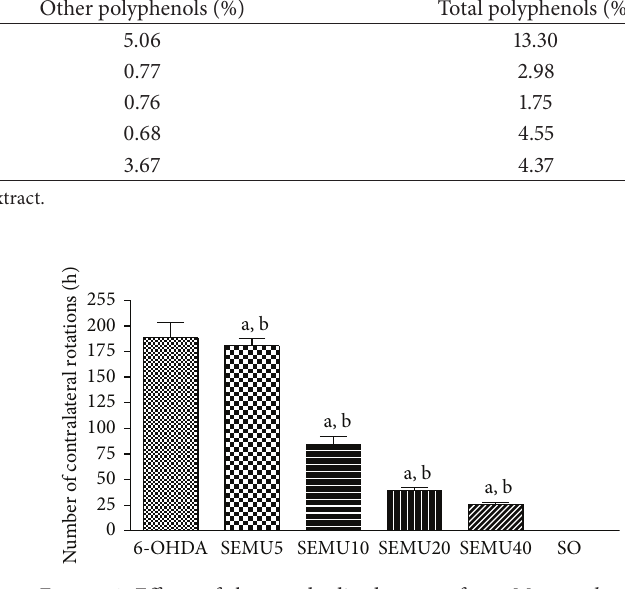
Figure 1: Effects of the standardized extract from M. urundeuva (SEMU) on the apomorphine-induced rotational behavior, in a rat model of Parkinson’s disease. SEMU (5, 10, 20, and 40 mg/kg, p.o.) was administered, 1 h after the stereotaxic surgery (unilateral injection of 6-OHDA into the right striatum) and daily for 14 days. The animals were observed for 1h, 30 min after the apomorphine injection (1mg/kg, s.c.). The values are means ± SEM from 5 animals per group. (a) 𝑃 < 0.01 versus 6-OHDA and (b) 𝑃 < 0.001 versus SO (one-way ANOVA and Newman-Keuls as the post hoc